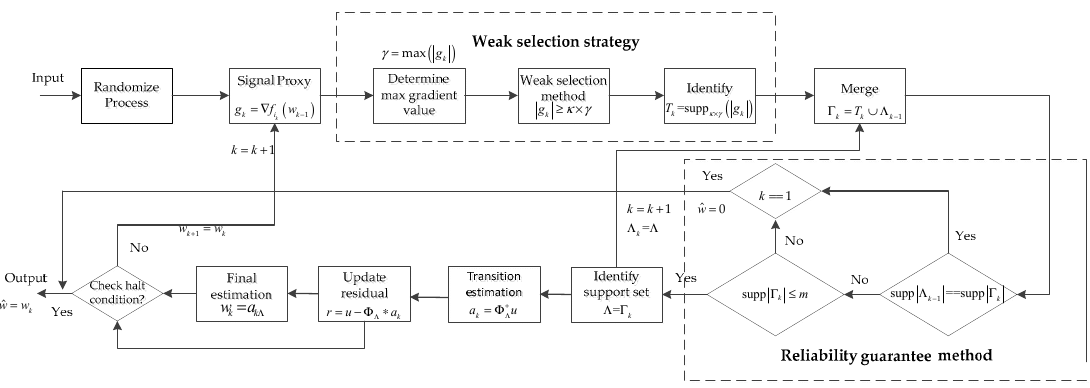
Figure 2. Block diagram of the proposed method.